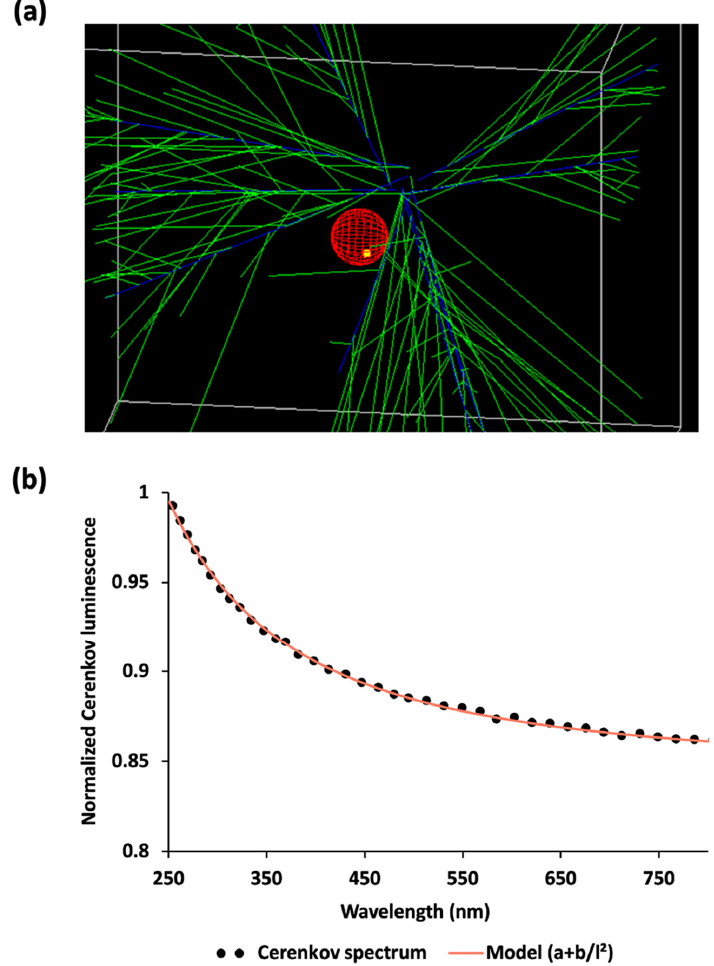
Figure 3. Cerenkov luminescence as simulated in Gate. ( a ) Snapshot of the defined geometry. Cerenkov photons (green) are emitted all along positron paths (blue), which may interact with cells (red) into which a cluster of nanoparticles have been defined (yellow). ( b ) Cerenkov spectrum (from 250 up to 800 nm) in water inside the main simulation volume.